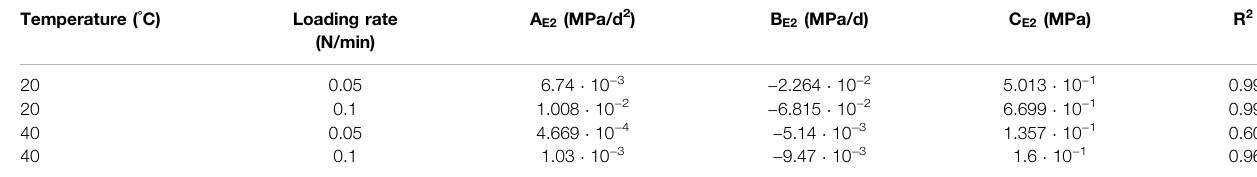
TABLE 5 | Transverse tensile modulus — parameters of fi ts. Temperature ( ° C)